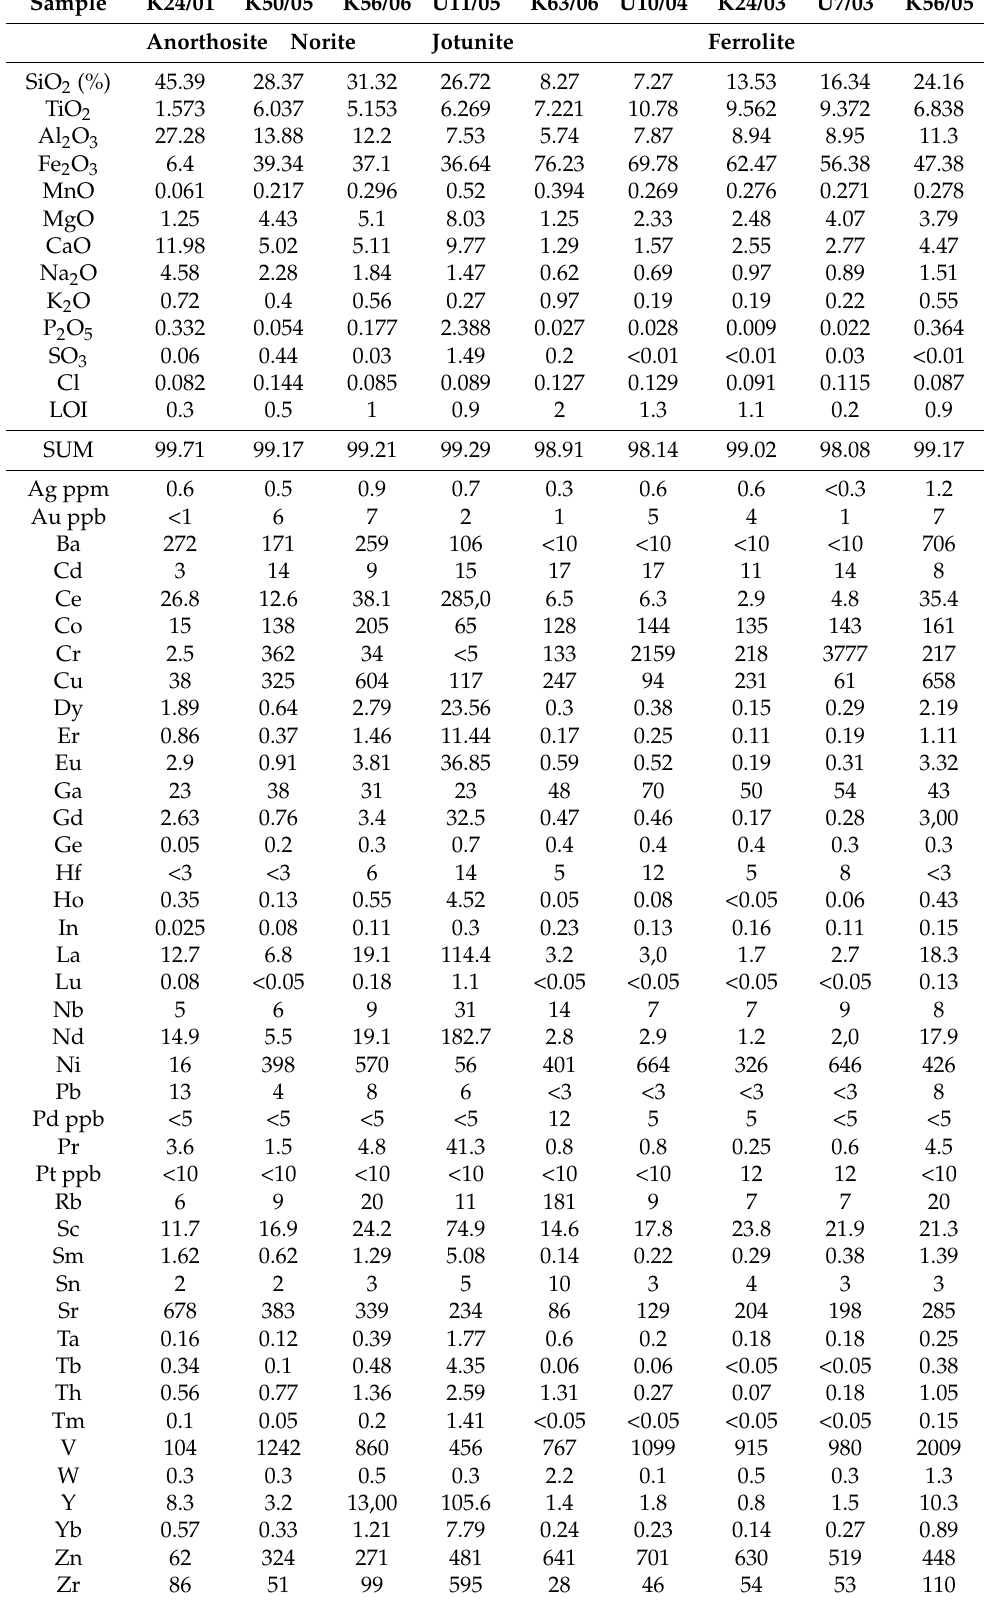
Table 6. Representative whole-rock chemistry of mineralized samples from the Fe-Ti-V deposits in